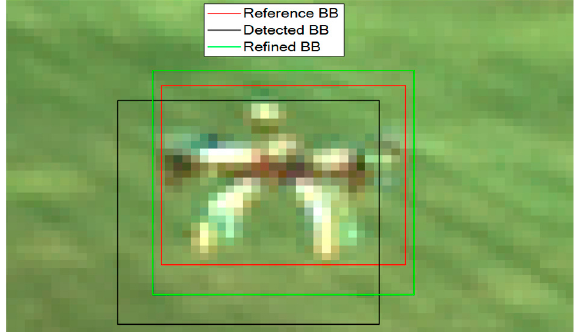
Figure 8. Result of the BB refinement algorithm. The IoU of the refined BB is 0.747.